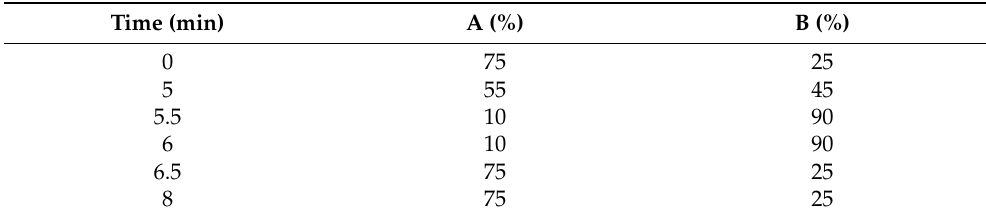
Table 3. A gradient HPLC program consisting of 0.1% formic acid aqueous solution ( A ) and 0.1% formic acid in acetonitrile ( B ).